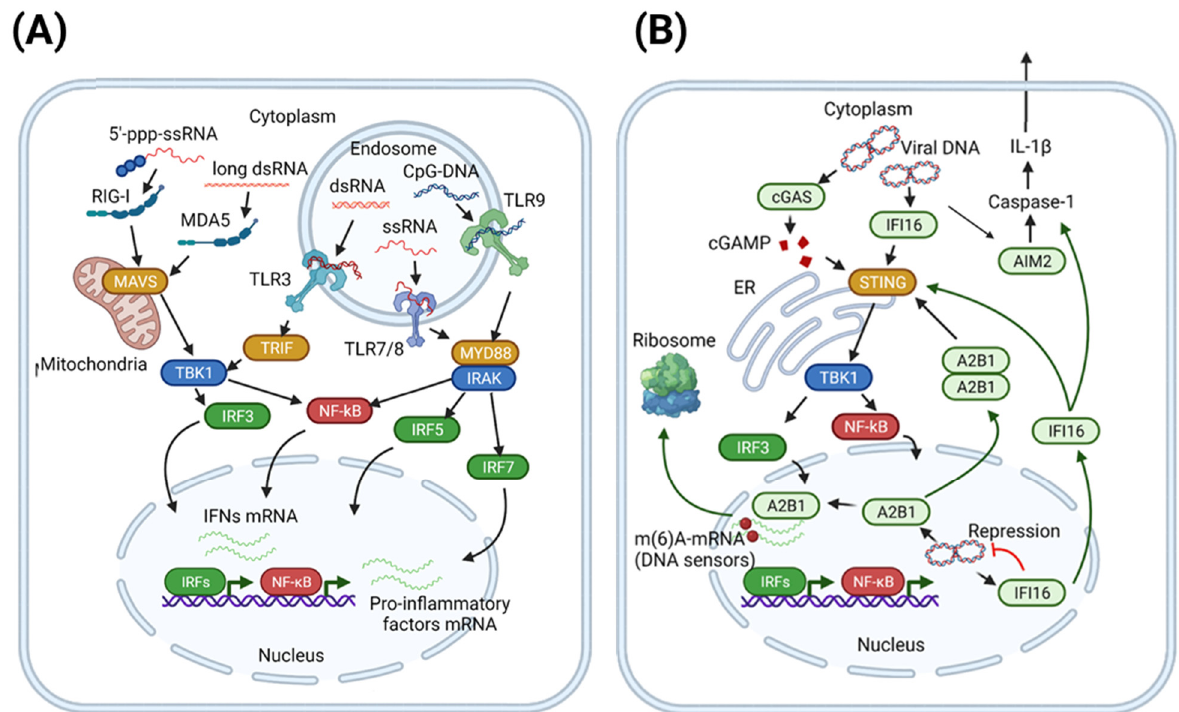
Figure 1. Sensing of foreign nucleic acids. ( A ) TLR- and RLR-mediated sensing of foreign nucleic acids. Different types of cytoplasmic foreign RNA are recognized by RIG-I or MDA5 sensors followed by activation of MAVS and downstream TBK1-IRF signaling. In endosomes, RNA and CpG-DNA activate TLRs that result in one of the two signaling pathways involving TRIF or MYD88-IRAK. Activation of IRFs induces the expression of interferons and mRNA of pro-inflammatory factors. ( B ) Cytoplasmic and nuclear sensors of foreign DNA. Cytoplasmic DNA can be sensed by a number of sensors, including IFI16, cGAS, and AIM2. The first two factors activate the STING pathway that ultimately induces TBK1/IRF and interferon secretion. Upon recognition of cytoplasmic DNA, AIM2 induces caspase-1-dependent maturation of pro-IL-1 β (pro-inflammatory response). A2B1 (hnRNPA2B1) and IFI16, among other factors, can participate in the sensing of foreign DNA in the nuclei of cells. IFI16 interferes with foreign nuclear DNA by epigenetic silencing, whereas A2B1 recognizes foreign DNA as well as activates and enhances innate antiviral responses. This picture was created in BioRender.